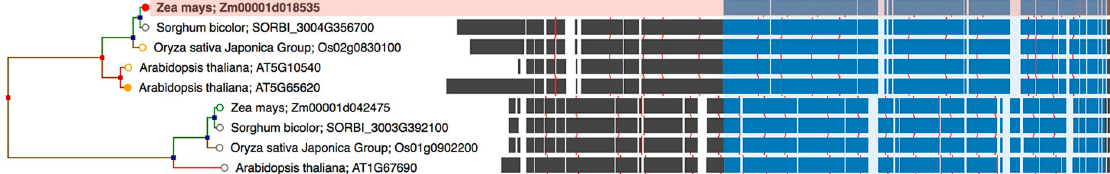
Fig 2. Triage of BRICK1 (Zm00001d018535) with the Gramene gene tree visualizer. Comparison to closest plant orthologs and maize paralogs revealed that the B73 RefGen_V4 model was missing the entire 5’ end. BRICK genes function in a common pathway to promote polarized cell division and cell morphogenesis in the maize leaf epidermis. The humans ortholog of BRICK1 (BRK1) is required for cell proliferation and cell transformation by oncogenes. Notably, patients with Von Hippel-Lindau syndrome normally develop tumors, but those lacking a functional Brk1 gene are protected from